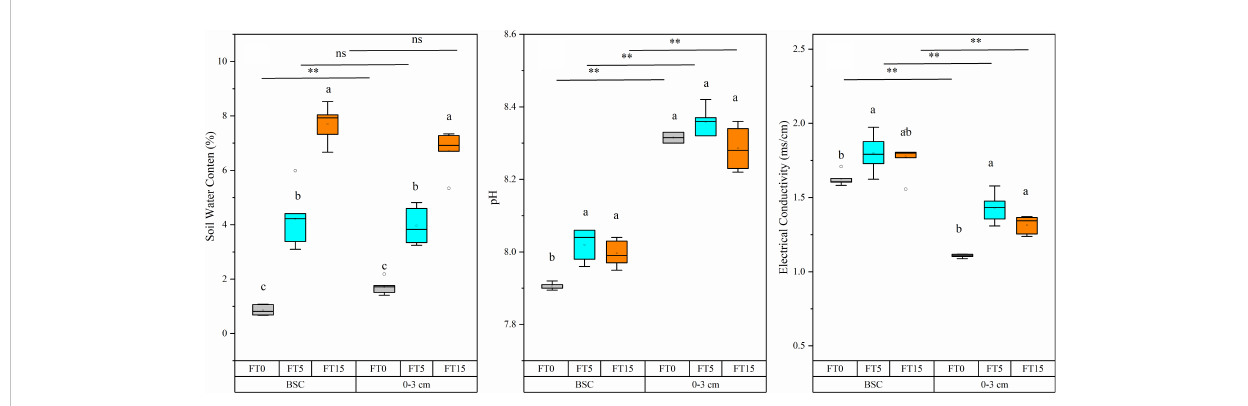
FIGURE 1 Effect of FTC on water content, pH, and electrical conductivity in different soil layers. Results are mean ± SE of fi ve independent replicates. Different lowercase and uppercase letters indicate signi fi cant differences between the FTC treatments (P < 0.05), **(P < 0.01), and ns (P > 0.05).